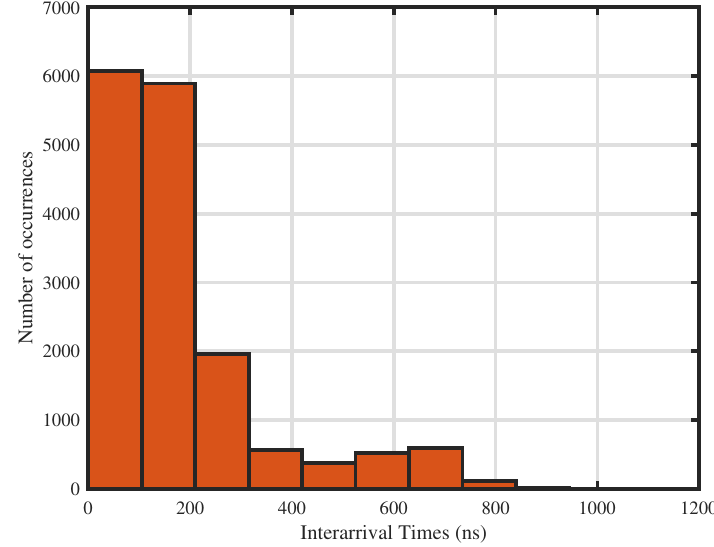
Figure 7. Histogram for the interarrival times of Operator 1 at Location